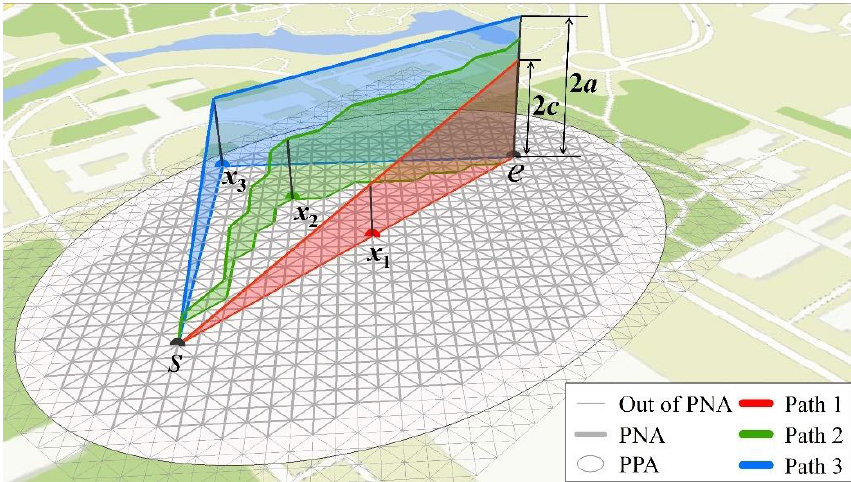
Figure 1. A PNA derived from a pedestrian network based on 8 neighborhoods in a homogeneous space and its three potential paths.